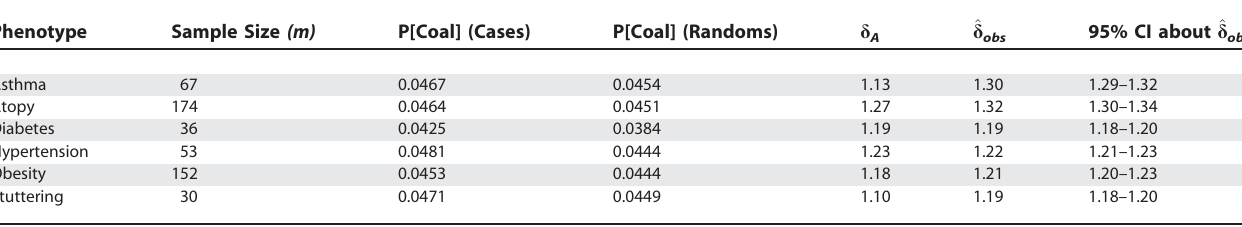
Table 3. Observed ð ^ d obs ) and Predicted ( d A ) Inflation Factors for Six Phenotypes Measured in the Hutterite Founder Population